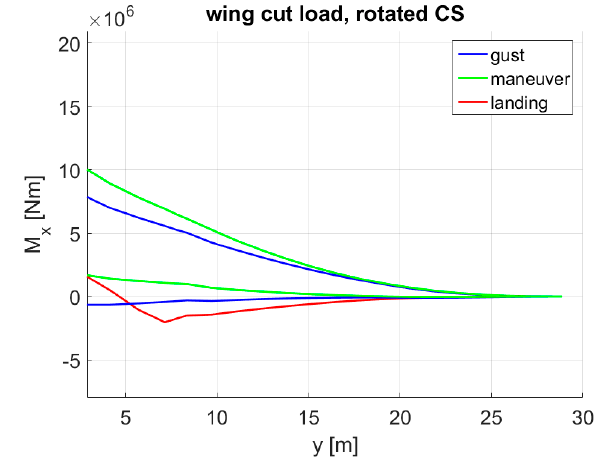
Figure 39. Bending moment envelope with red. safety factor.